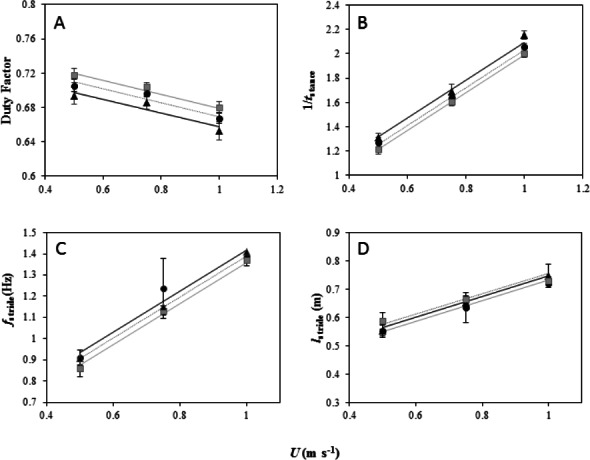
Foot kinematics of peacocks moving on a level treadmill (black dotted line and black, triangle markers) and at inclines of 5° (black dotted line and black circle markers) and 7° (grey solid line and grey, square markers).All 6 birds performed the first 2 speeds on the level and at each incline and 4 birds performed the top speed at the highest incline. (A) Duty factor (mean ± s.e.m) plotted against forward speed (U) for each gradient. The lines fitted through the data (from the LME model output) are Pmet = 0.73 + − 0.08U for peacocks moving on a level gradient, Pmet = 0.75 + − 0.08U for peacocks moving on a 5° incline and Pmet = 0.75 + − 0.08U for peacocks moving on a 7° incline. (B) Inverse of contact time (1/tstance) plotted against forward speed (U) for each gradient. The lines from the model output are Pmet = 0.53 + 1.55U for peacocks moving on a level gradient, Pmet = 0.47 + 1.55U for peacocks moving on a 5° incline and Pmet = 0.43 + 1.55U for peacocks moving on a 7° incline. (C) fstride plotted against forward speed (U) for each gradient. The lines from the model output are Pmet = 0.42 + 0.96U for peacocks moving on a level gradient, Pmet = 0.44 + 0.96U for peacocks moving on a 5° incline and Pmet = 0.39 + 0.96U for peacocks moving on a 7° incline. (D) lstride plotted against forward speed (U) for each gradient. The lines from the model output are Pmet = 0.38 + 0.36U for peacocks moving on a level gradient, Pmet = 0.36 + 0.36U for peacocks moving on a 5° incline and Pmet = 0.39 + 0.36U for peacocks moving on a 7° incline.